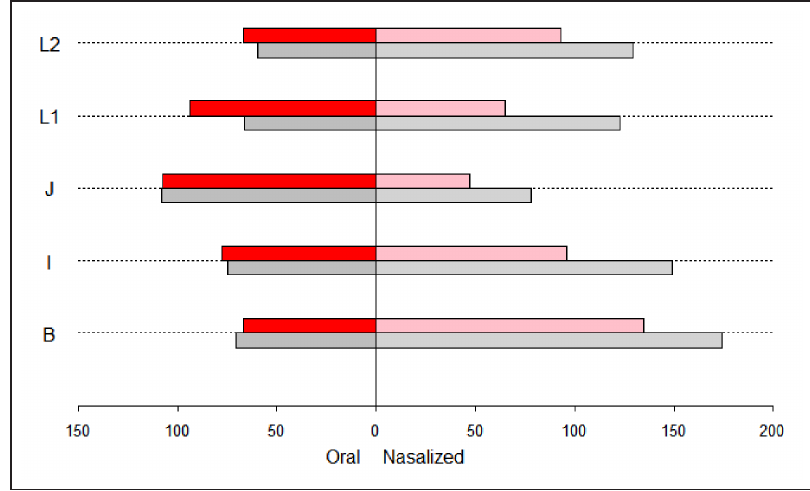
Figure 5: Mean duration (ms) of the oral and the nasalized portion of the vowel before [s] (grey/light grey) or [t] (red/pink) by participant. Zero indicates nasal